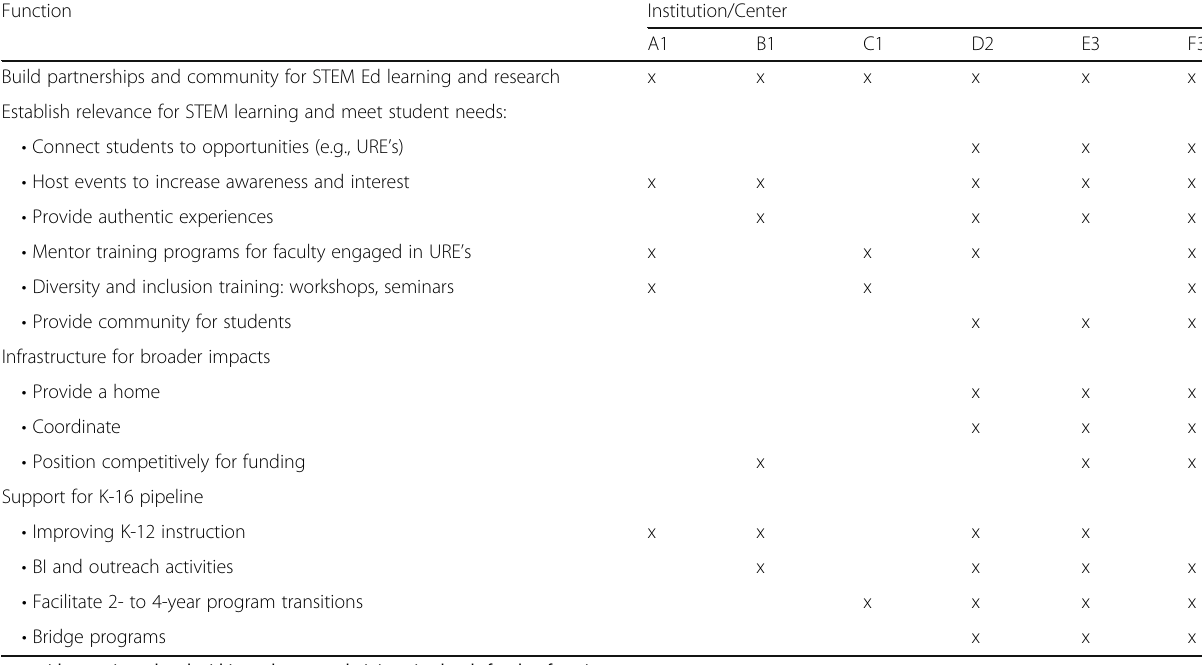
Table 5 SEC functions directed toward broadening participation and institutional capacity in undergraduate STEM